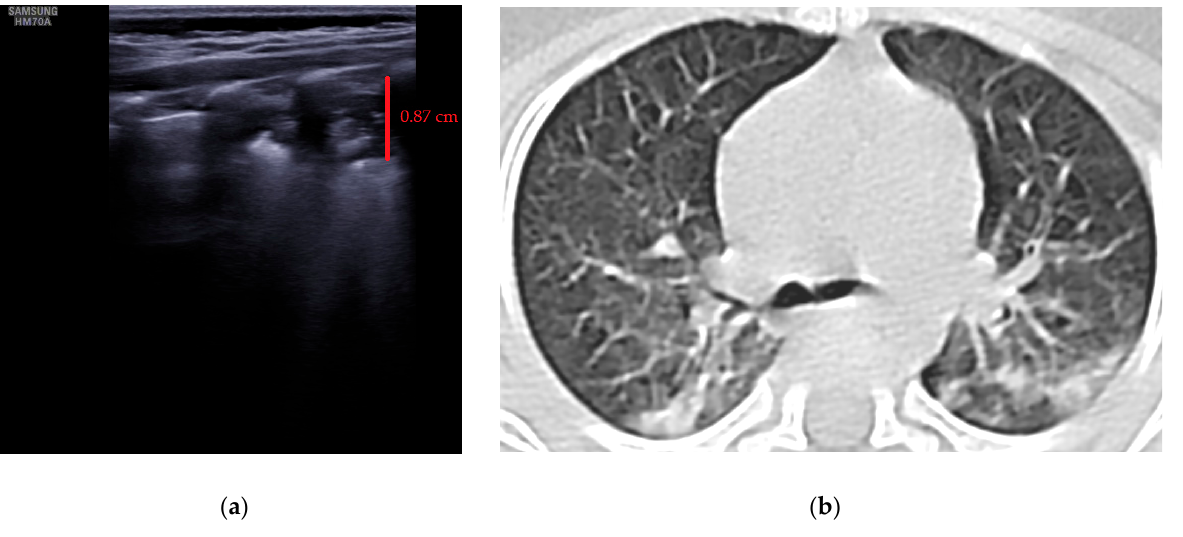
Figure 4. ( a ) The lung ultrasound showed a small consolidation area with the length <1 cm corresponding to a LUSS = 2; ( b ) The CT exam revealed bilateral consolidations in the posterior segments.